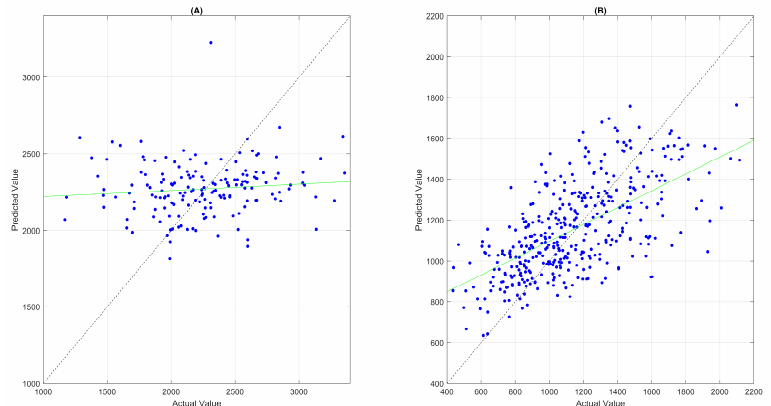
Figure 5. Correlation of actual values (horizontal axis) with predicted values (vertical axis) for ( A ) long-term upper bounds of g02 estimated from the SHMU input attributes, and ( B ) field-measured values of g02 estimated from the satellite-derived attributes and the measurement date.